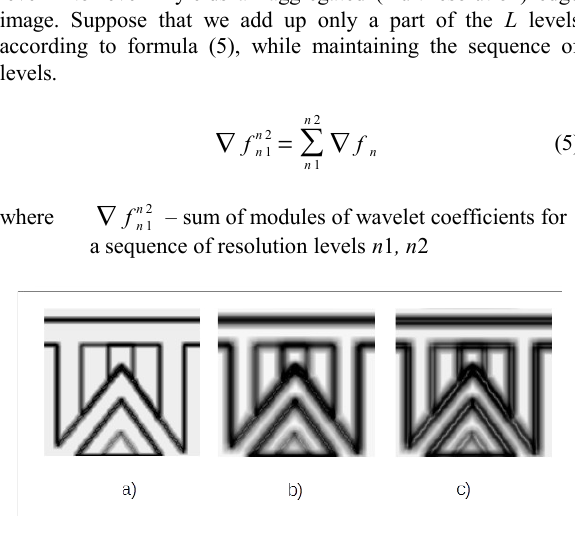
Figure 4. Example of aggregated edges for the artificial test image (see Figure